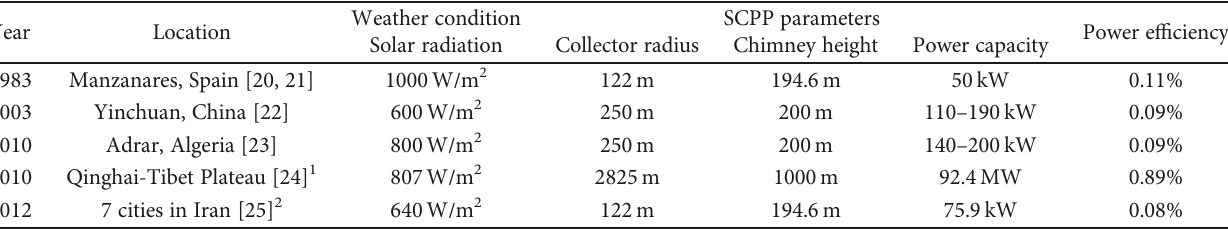
Table 1: Parameters of some case studies of